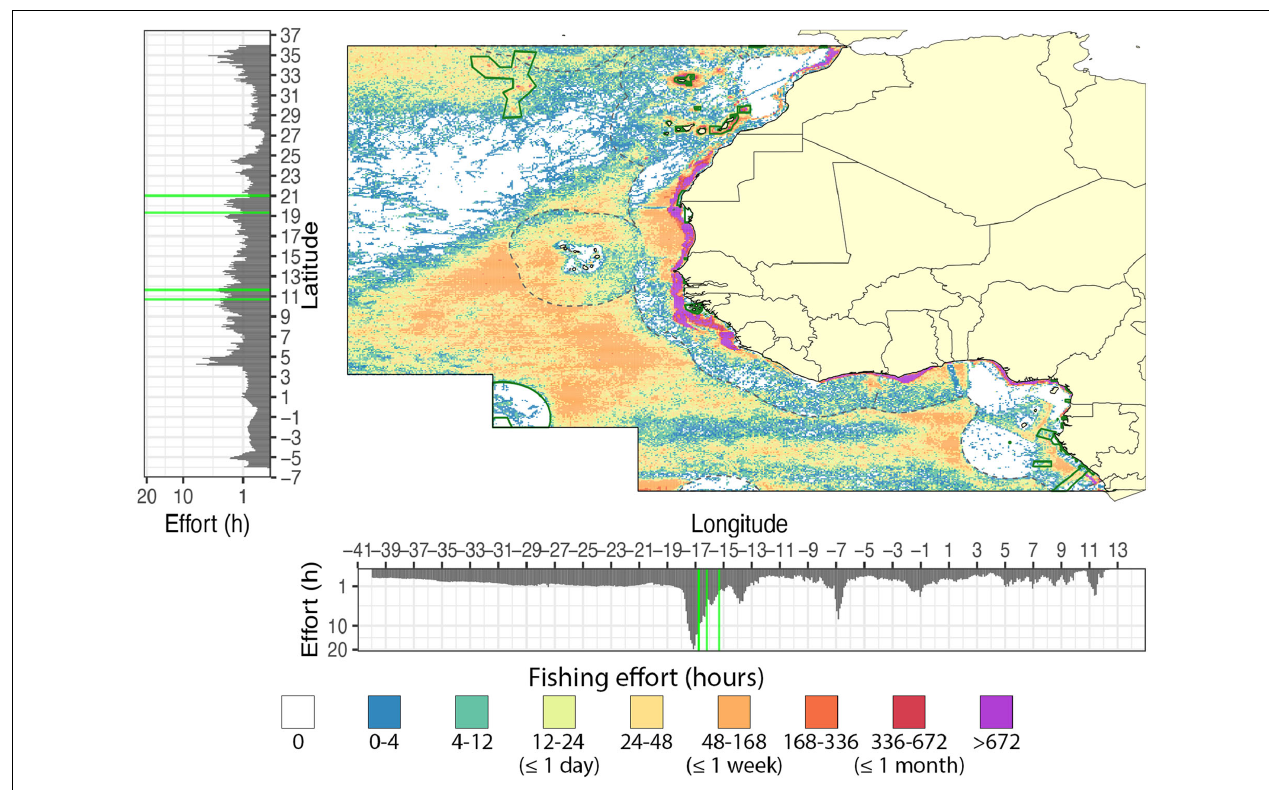
FIGURE 2 | Total fishing effort off West Africa from 2012 to 2018. Color scale indicates the total hours of fishing within each grid cell (low = blue, moderate = yellow/orange, and high = purple). Histograms on the axis show the total fishing effort in hours over the longitudinal and latitudinal range of the region. The longitudinal and latitudinal ranges of both MPAs are indicated with green lines.